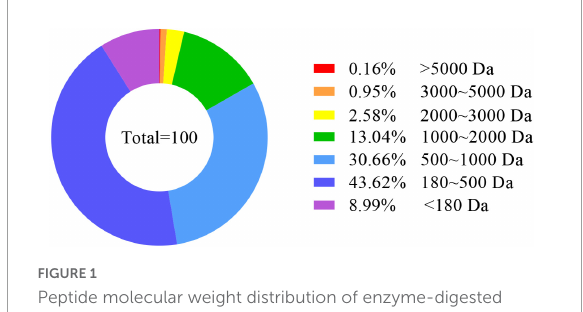
FIGURE1 Peptide molecular weight distribution of enzyme-digested poultry by-product meal. Da,